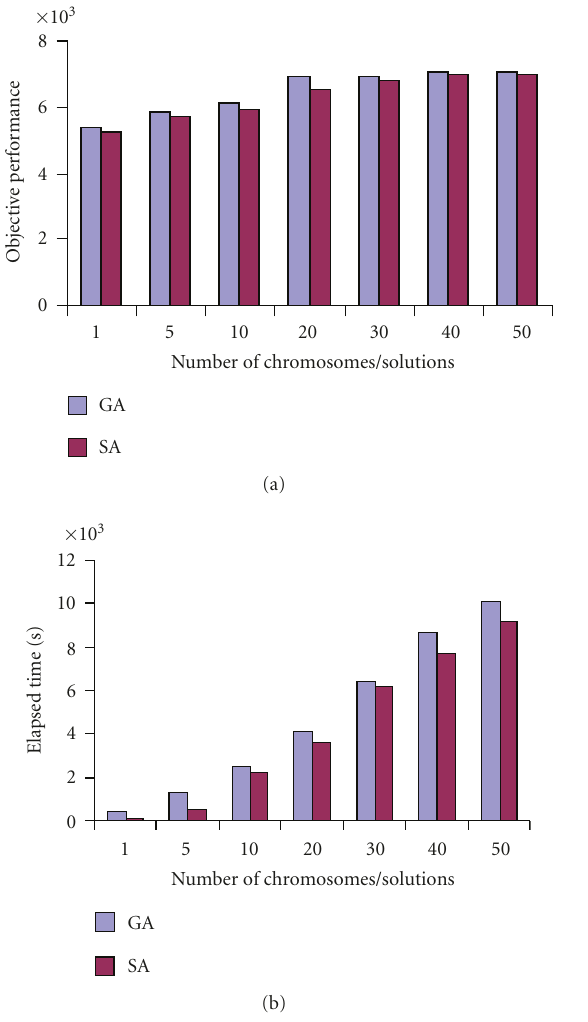
Figure 7: A comparison between genetic and simulated annealing algorithms with di ff erent chromosomes/solutions per iteration: (a) objective performance and (b) elapsed time.